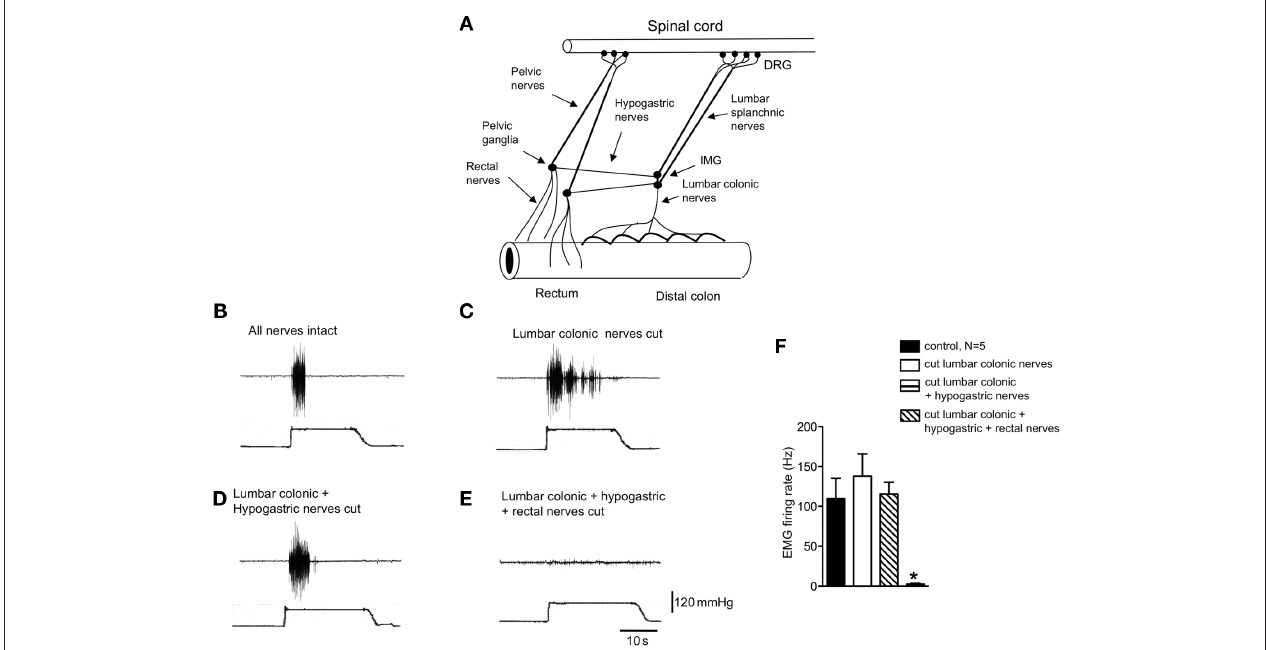
lesions applied to the hypogastric nerves also did not reduce the VMRs. (e) However, cutting of the rectal nerves abolished the visceromotor responses. (F) Shows the mean grouped data of VMRs evoked by acute noxious colorectal distension after lesions applied to the lumbar colonic, hypogastric, and rectal nerve trunks from N = 5 animals. * Refers to significant difference ( P <